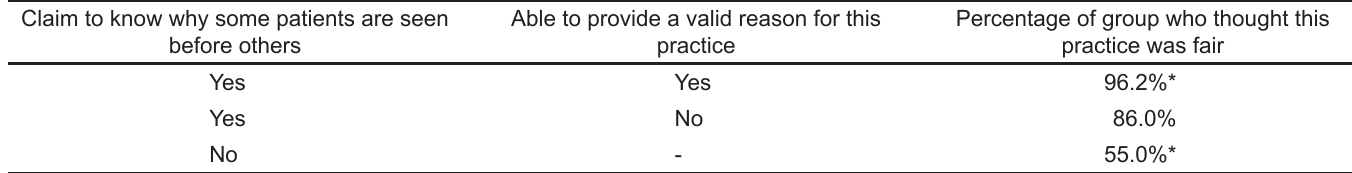
PCP , primary care physician Table 2. Proportion of respondents reporting it is fair to see some patients before others despite later arrival, stratified by self-reported knowledge of why this occurs and ability to provide a valid reason why it does.